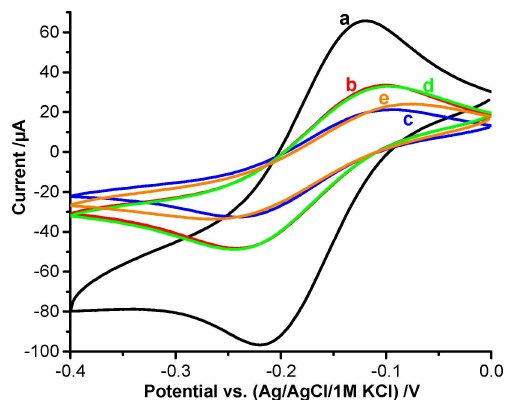
Figure 2. CVs of the redox marker [Ru(NH 3 ) 6 ] 2+ for the different steps of MIP preparation (5 mM [Ru(NH 3 ) 6 ] 2+ in 100 mM NaCl, pH 8, 100 mV/s): a—bare Au wire, b—after SAM-formation, c—after electropolymerization in presence of the template HTHP, d—after removal of HTHP, e—after rebinding in 1.3 mM HTHP solution for 1